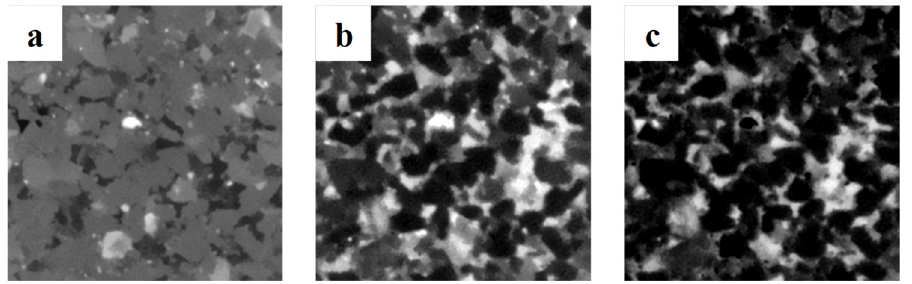
Figure 3. Two-dimensional cross-sections of three-dimensional micro-CT images at the same location in the sample. ( a ) The dry scanning image, ( b ) The brine-saturated image, ( c ) The difference image between ( b , a ).